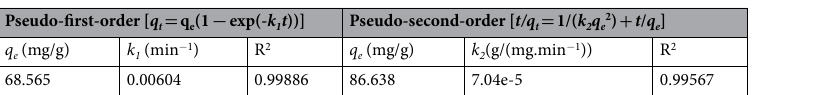
Pseudo-first-order [ q t = q e (1 − exp(- k 1 t ))]